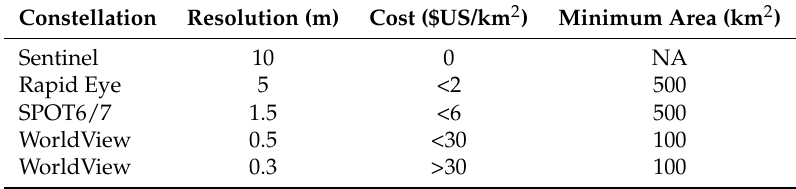
Table 11. Satellite constellations and approximate costs for four-band tasked images